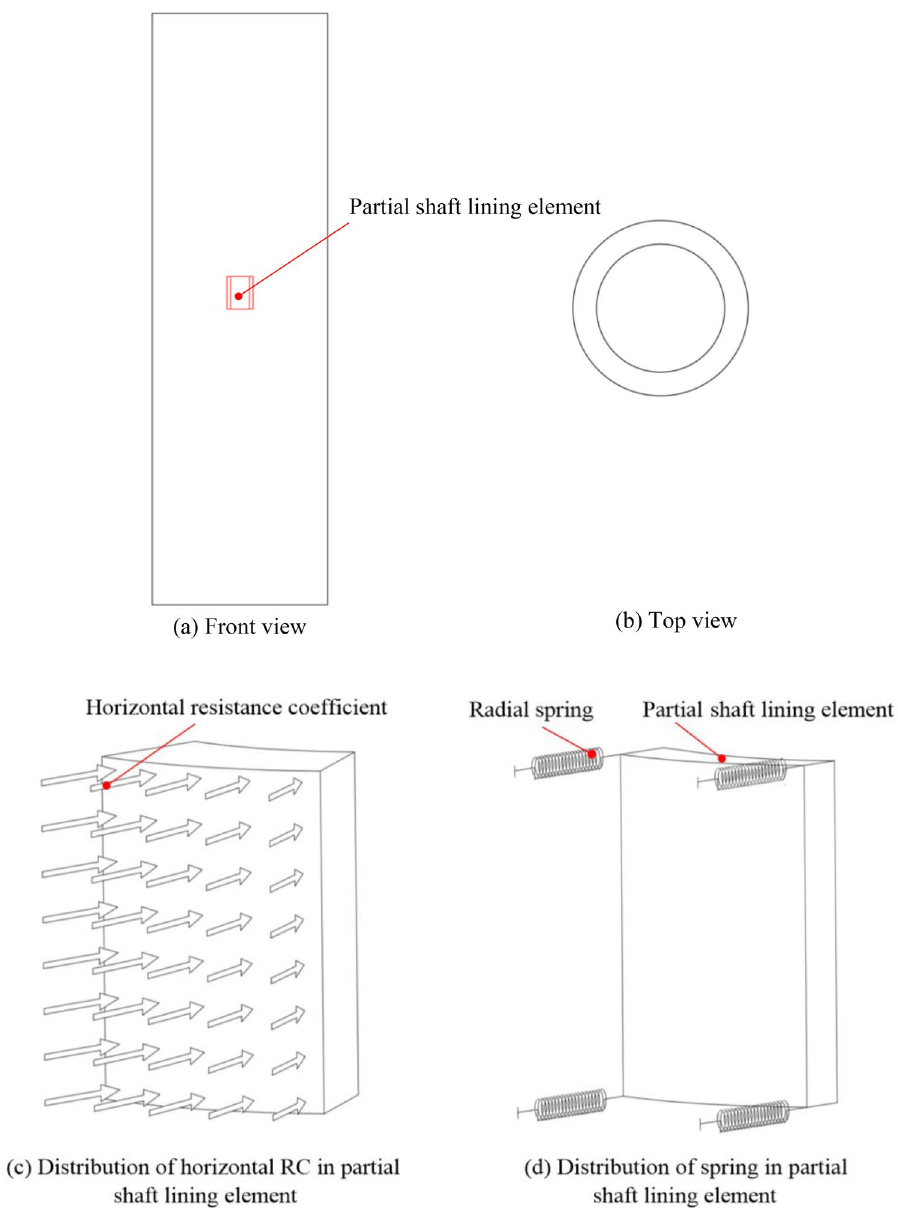
Figure 2. Schematic diagram of the simplification action of